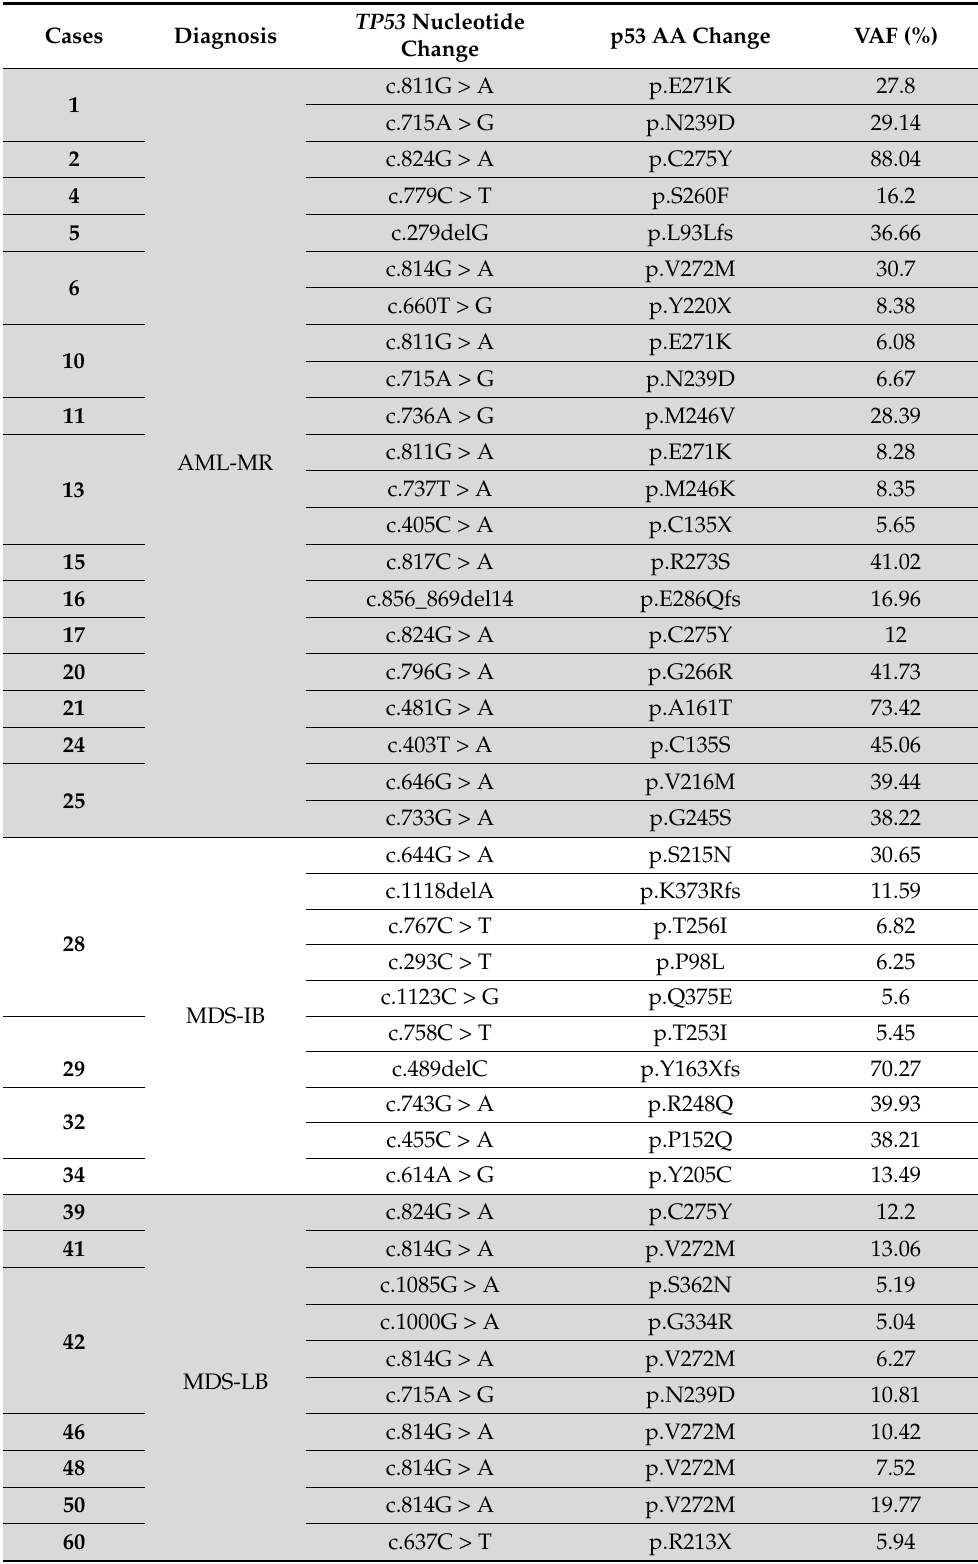
Table 2. Detected TP53 mutations and variant allele frequency